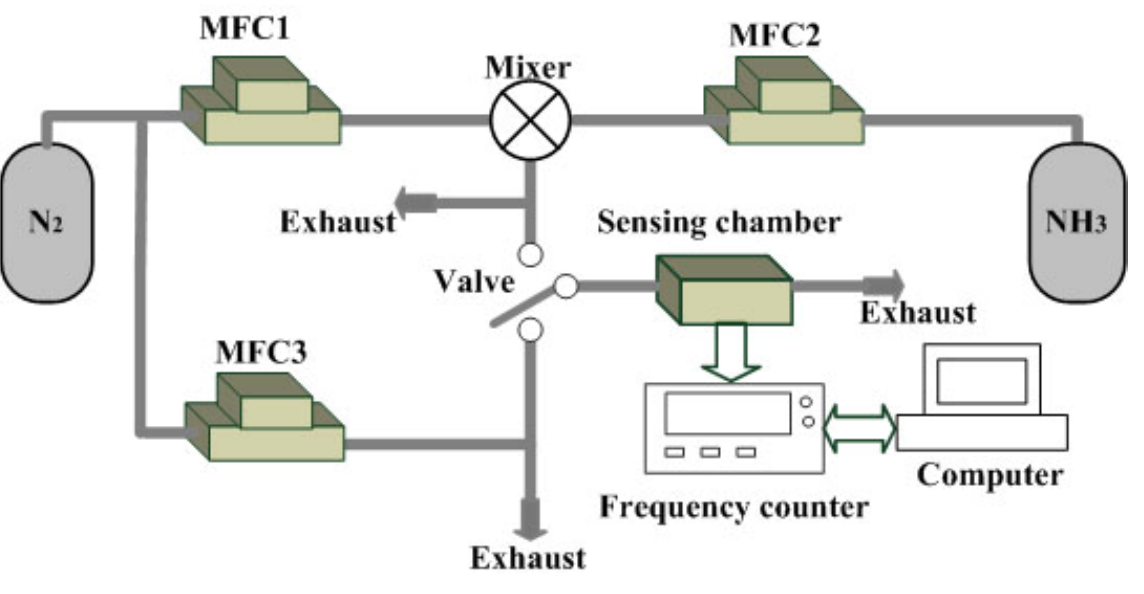
Figure 7. Schematic diagram of a gas testing system for ammonia detection.